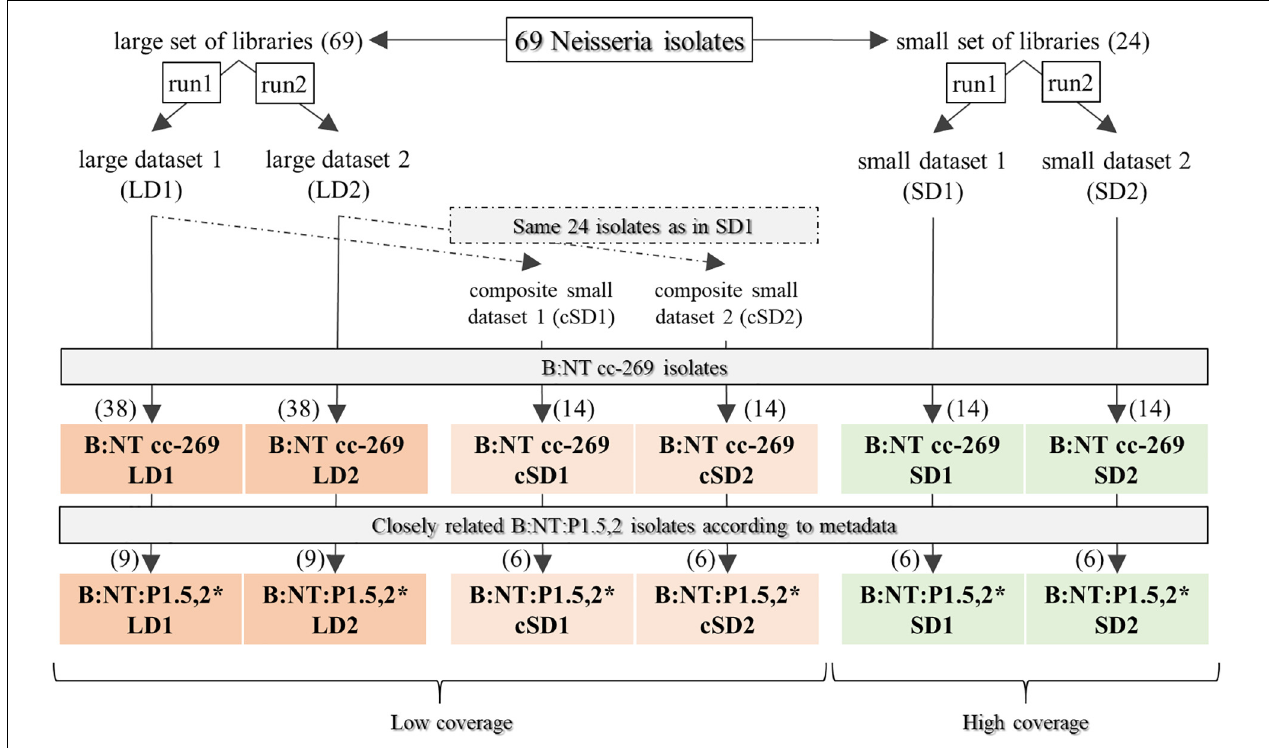
FIGURE 2 | Datasets. From the original collection of 69 isolates ( Table 1 ), two sets of Illumina libraries of 69 and 24 isolates respectively, were generated and sequenced yielding two pairs of replicate datasets with a different mean coverage: large dataset 1 (LD1) and large dataset 2 (LD2) originating from the 69-isolates library, and small dataset 1 (SD1) and small dataset 2 (SD2) originating from the 24-isolates library. Isolates that can be subtyped using a single reference genome were selected by KmerID, which attributed 38 isolates from the two LDs (referred to as B:NT cc-269 LD1 and B:NT cc-269 LD2), and 14 isolates from the SDs (B:NT cc-269 SD1 and B:NT cc-269 SD2) to the reference genome from clonal complex (cc) 269. The two cc-269 LDs and the two cc-269 SDs were used to evaluate pipeline stability toward inter-run variation. To evaluate the coverage sensitivity of the pipelines, composite small datasets (cSDs), were created, composed from data of the two LDs and containing the same 24 isolates as the SDs. Thereby, B:NT cc-269 cSDs were used as the low-coverage data, while the two B:NT cc-269 SDs represented the high-coverage data. The 38 B:NT cc-269 isolates (14 for SDs) selected for subtyping with the ST269 reference genome belonged to